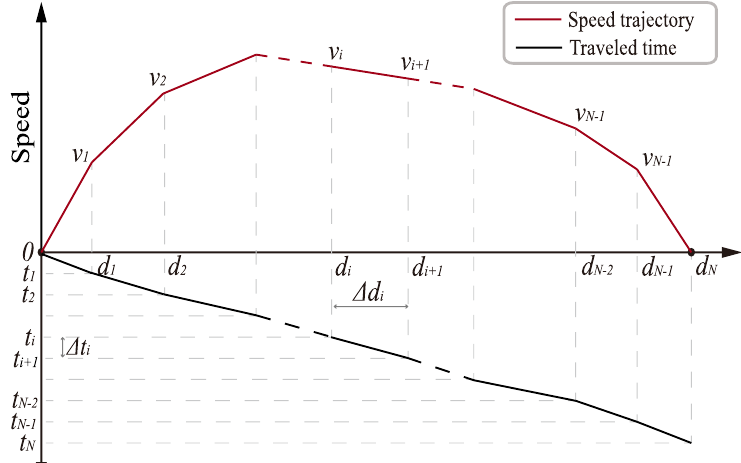
Figure 1. The discretization process of speed trajectory based on time and distance. v i is the speed at d i ; t i is the time required for the train to reach the distance d i . The time elapsed and distance traveled between two adjacent speeds are ∆ t i and ∆ d i ,